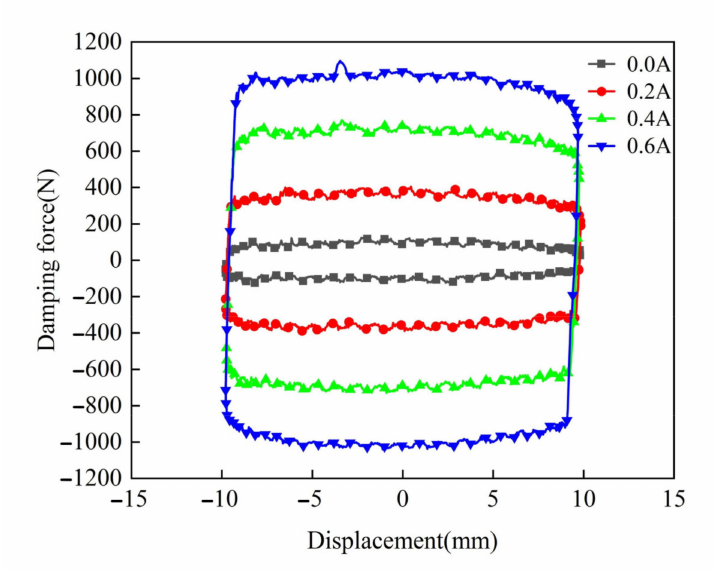
Figure 15. Relationship of force and displacement under different current experimental